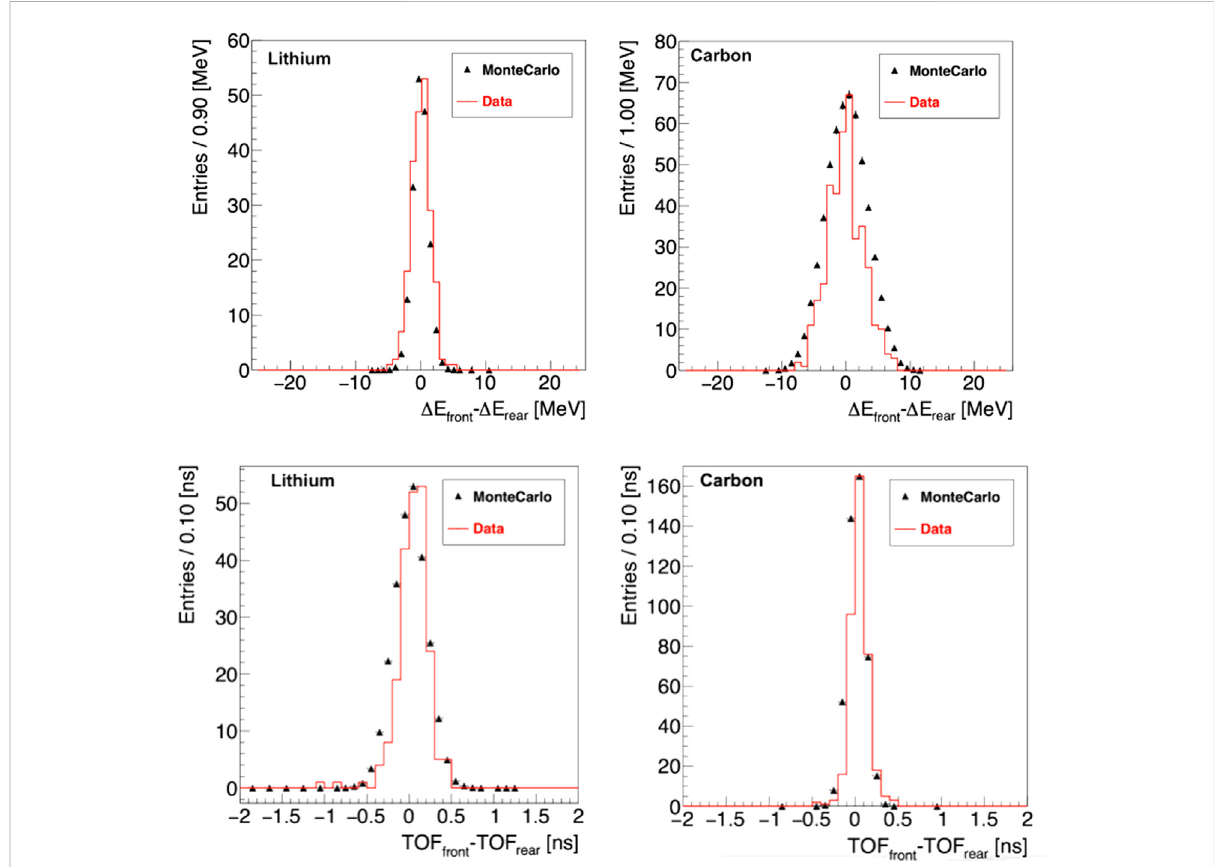
FIGURE 8 Comparison of Δ E and the TOF taken from the 2 TW layers extracted from GSI data and from MC reconstructed simulations of a 16 O beam at 400 MeV/u on a C target, for Z = 3 and Z = 6. The MC distributions were normalized to data